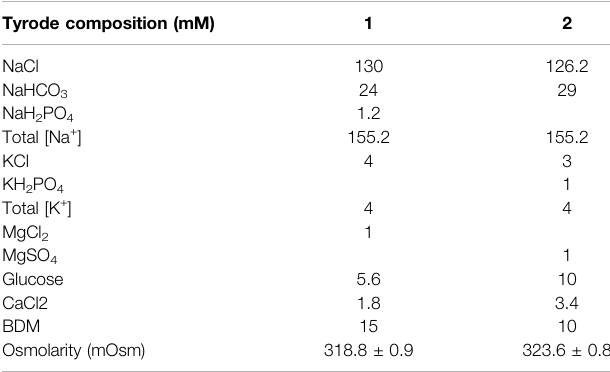
TABLE 1| Composition ofthetwoperfusate solutionsused tomodulate perinexal width (W P ) during the perfused mouse heart experiments. Osmolarity values presented as mean ± standard